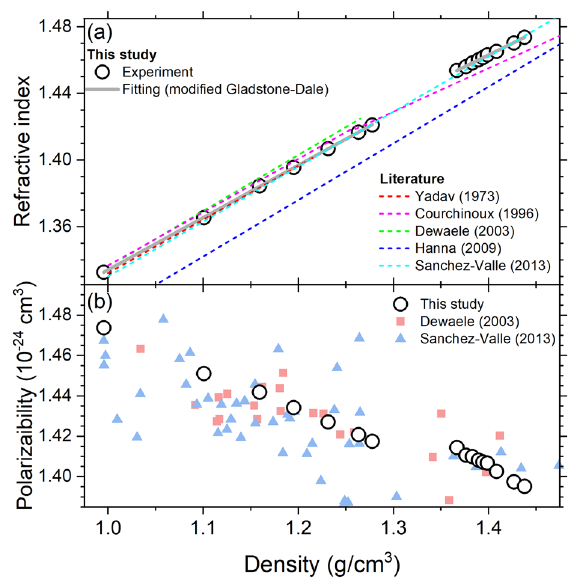
Figure 7. ( a ) Refractive index of water as a function of density. Our datasets in liquid and ice VI phases are fitted with a modified Gladstone–Dale model and compared with the model equations in the literatures 12,18,26,41,42 . ( b ) Molecular polarizability calculated using the Lorentz–Lorens model with literature values 12,18